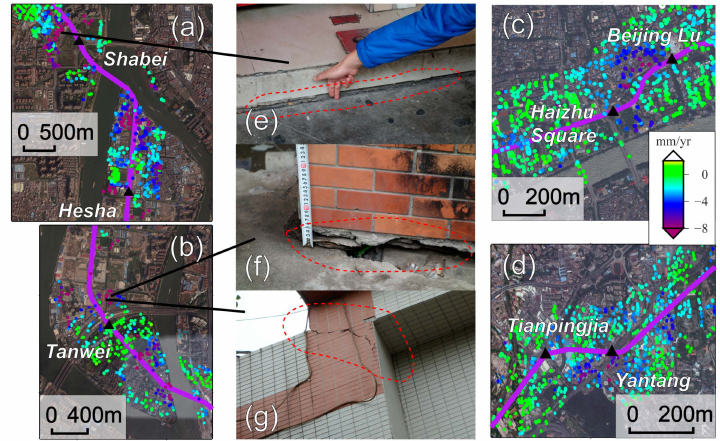
Figure 7. ( a – d ) The deformation rate maps of four subsiding areas along Line Six. ( e – g ) The field investigation